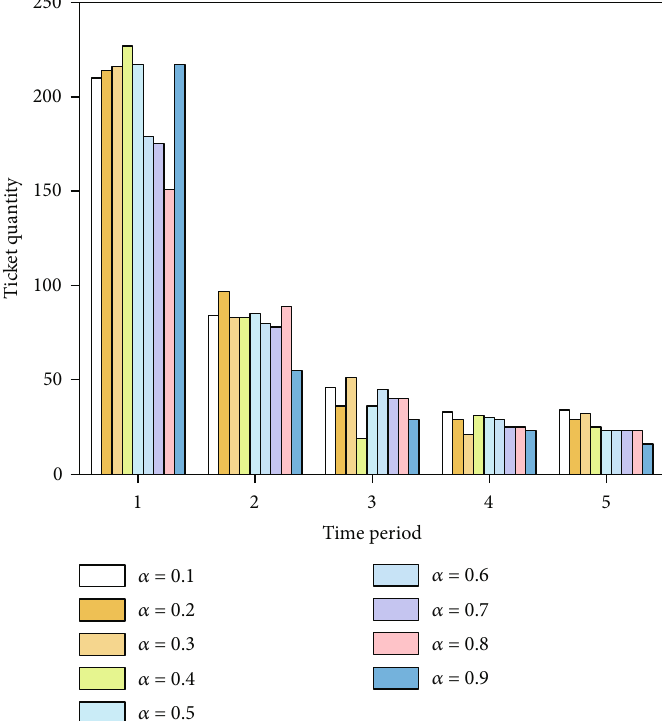
Figure 12: Ticket quantity of train A in OD